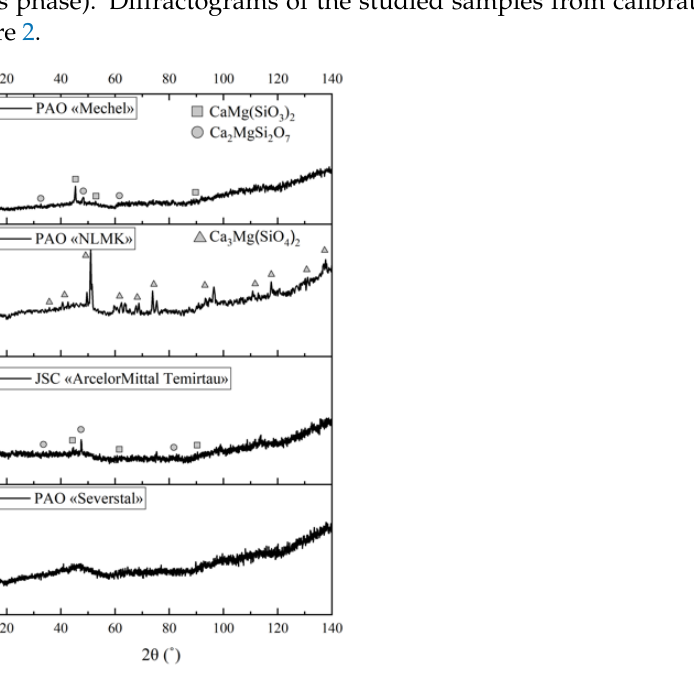
Figure 2. Diffractograms of granulated blast furnace slag from calibration set (PAO Severstal, PAO NLMK, PAO Mechel and JSC ArcelorMittal Temirtau). The diffractogram of PAO Severstal granulated blast furnace slag does not show pronounced reflexes corresponding to crystalline phases. The sample contains a significant amount of glass